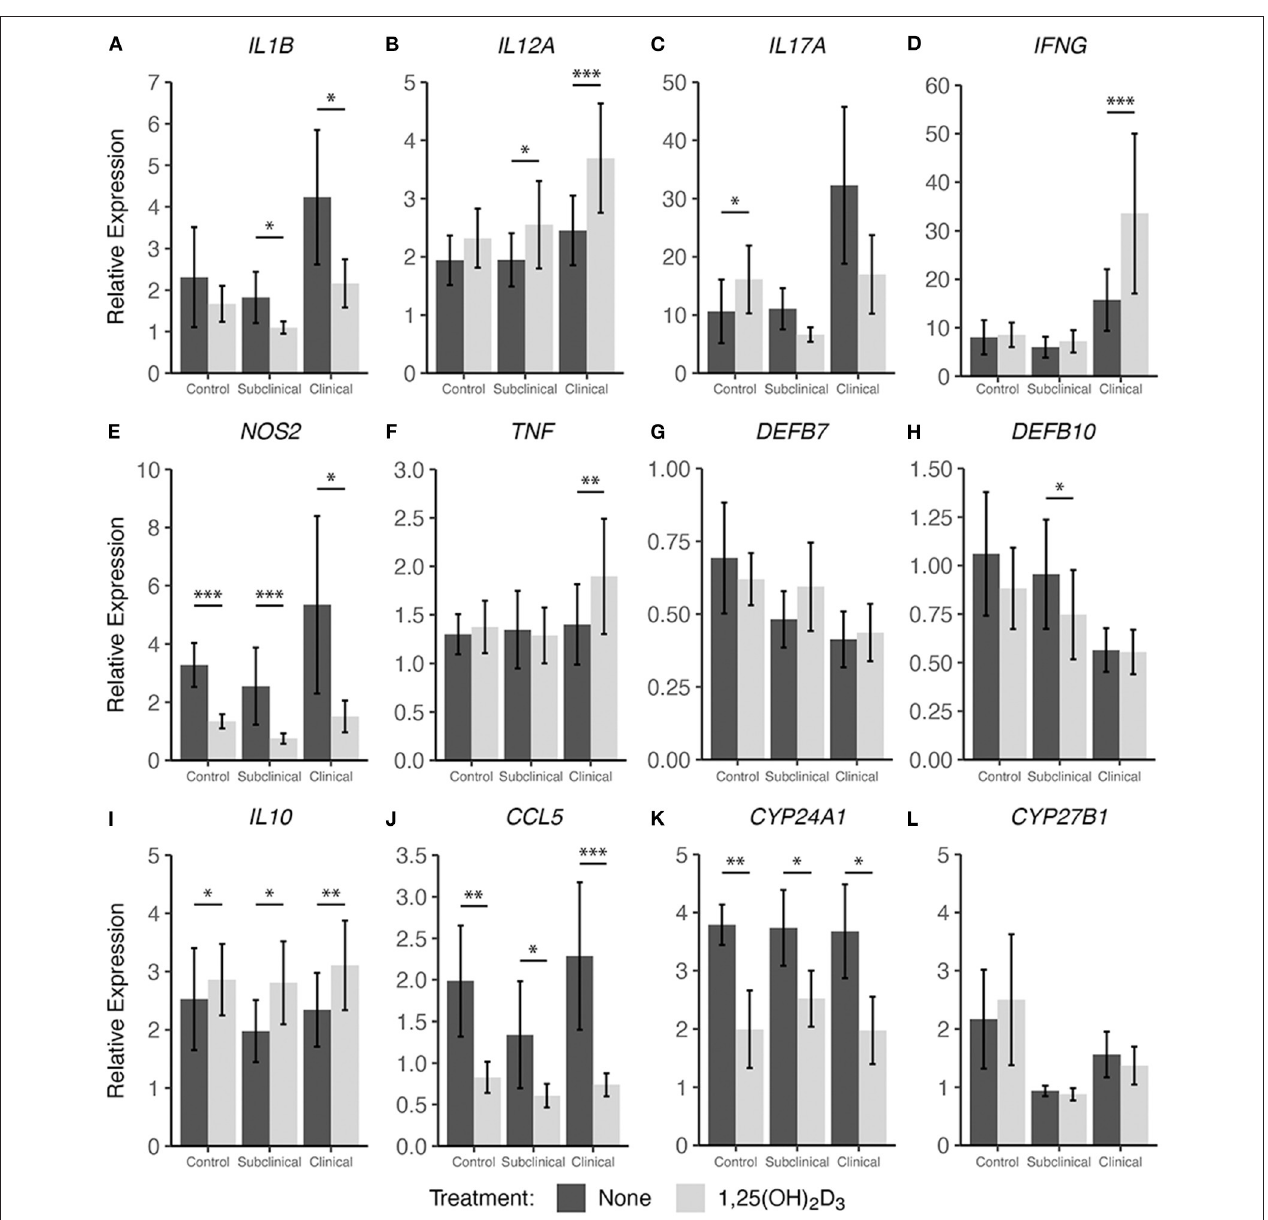
FIGURE 4 | Cytokine gene expression from PBMCs isolated from naturally infected dairy cattle (subclinical n = 8 and clinical n = 8) or noninfected controls ( n = 8). Cells were cultured 24 hrs with culture media or whole cell MAP sonicate (MPS) ± 4ng/ml 1,25(OH) 2 D 3 . Extraction and purification of RNA was performed using Qiagen RNeasy Mini kits and was reverse transcribed with Superscript IV. Gene expression for (A) IL1B , (B) IL12A , (C) IL17A , (D) IFNG , (E) NOS2 , (F) TNF , (G) DEFB7 , (H) DEFB10 , (I) IL10 , (J) CCL5 , (K) CYP24A1 , and (L) CYP27B1 were determined using TaqMan assays and were normalized to eukaryotic 18S rRNA reference gene. Data were analyzed using the 2 − 11 Ct method and are presented as the mean relative gene expression (RQ) ± SE compared to each sample’s respective non-stimulated (NS) control. Statistics were performed on 11 Ct values and significance levels are as follows: * < 0.05,** < 0.01,*** <